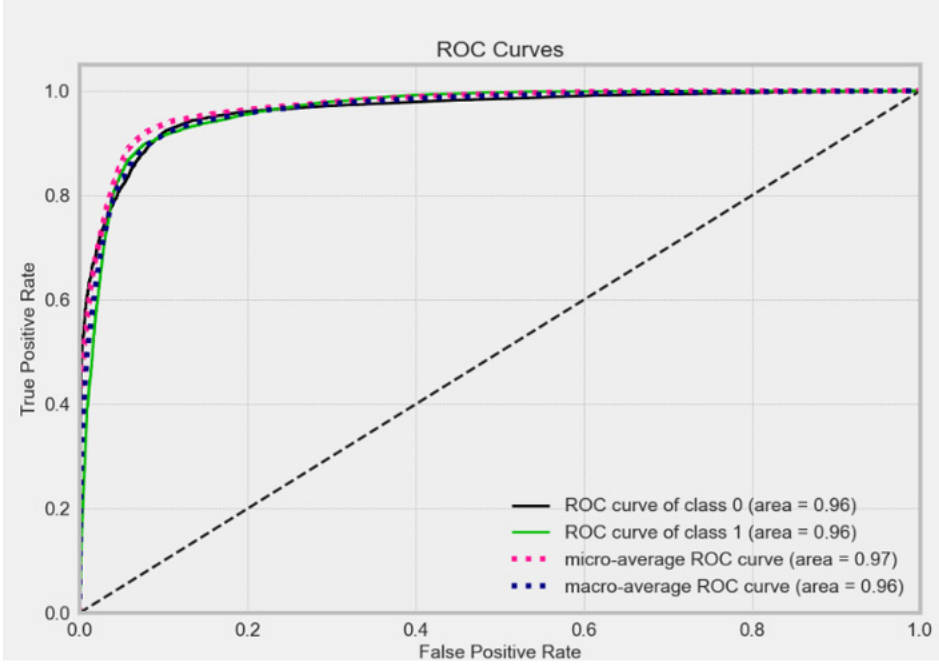
Figure 15. Normalized Confusion matrix for XGBoost model.